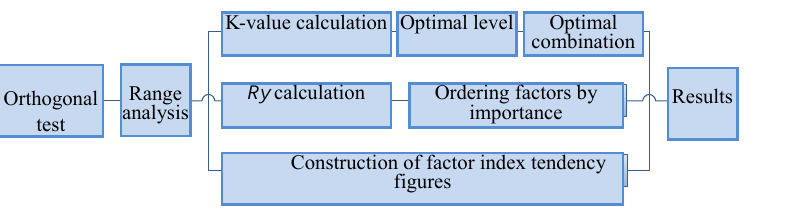
Figure 8. Flow chart for the optimization analysis of the test. R y is the range in factor y . The K value is the sum of the statistical test results.